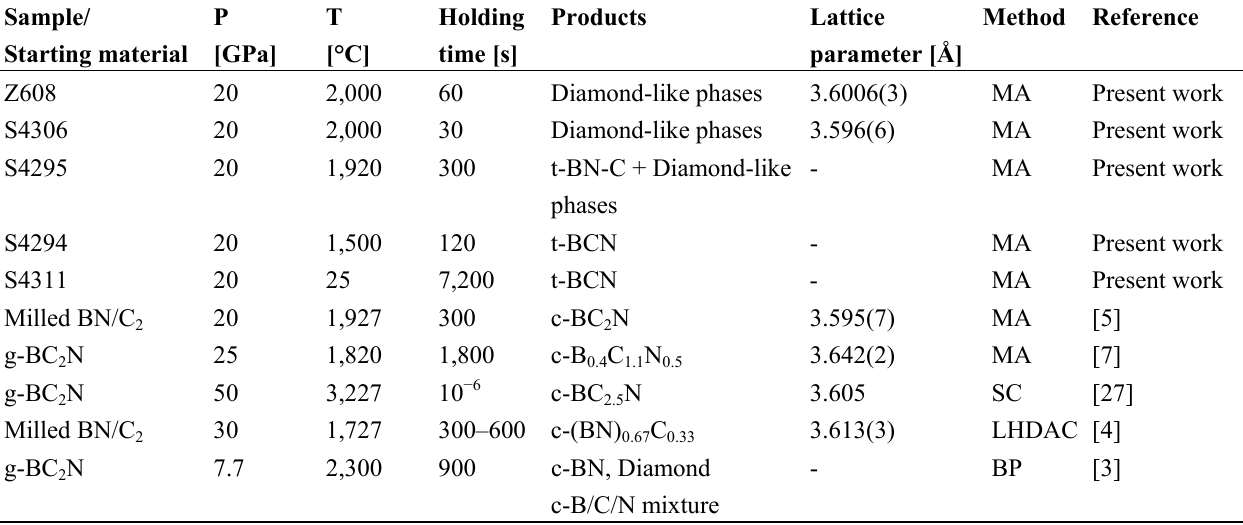
Table 3. Summary of synthesis HP/HT conditions, final products, and refined lattice parameters ( GSAS Software Package ) [29] of the present B-N-C materials in comparison to previously obtained c-BC N 2